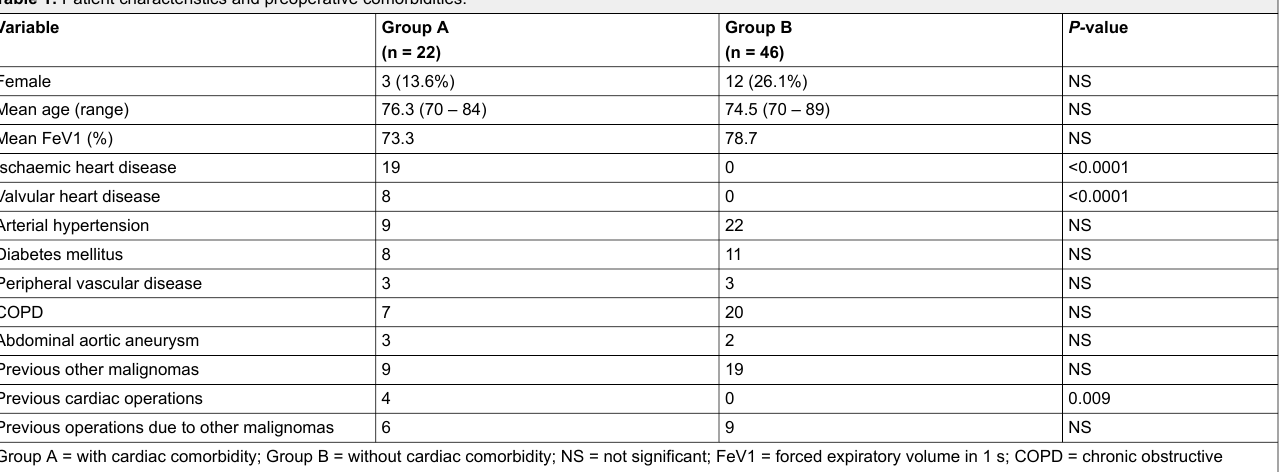
Table 2 : Cardiac history in Group A. Cardiac event Patient no.